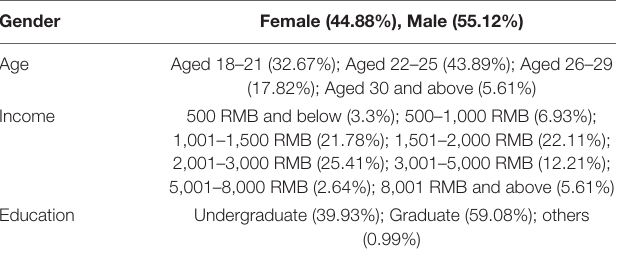
TABLE 1 | Demographic descriptive statistics ( N =